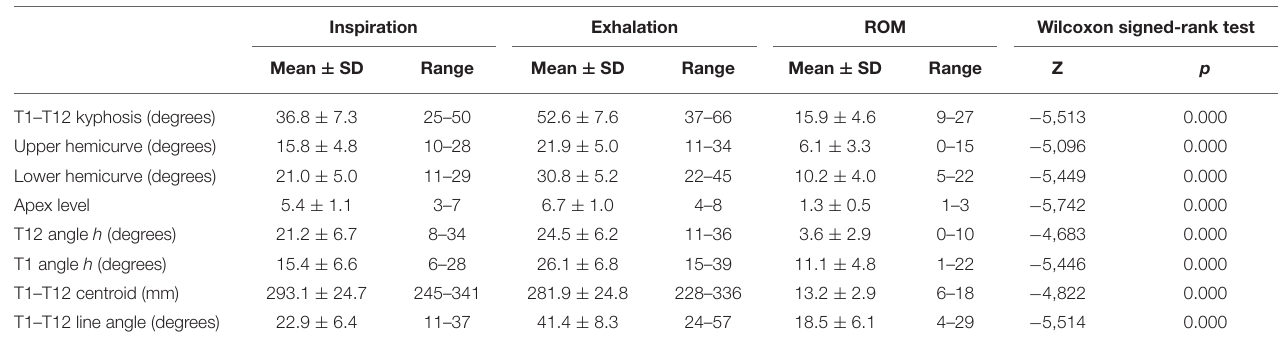
TABLE 3 | Movements of the thoracic spine on the sagittal